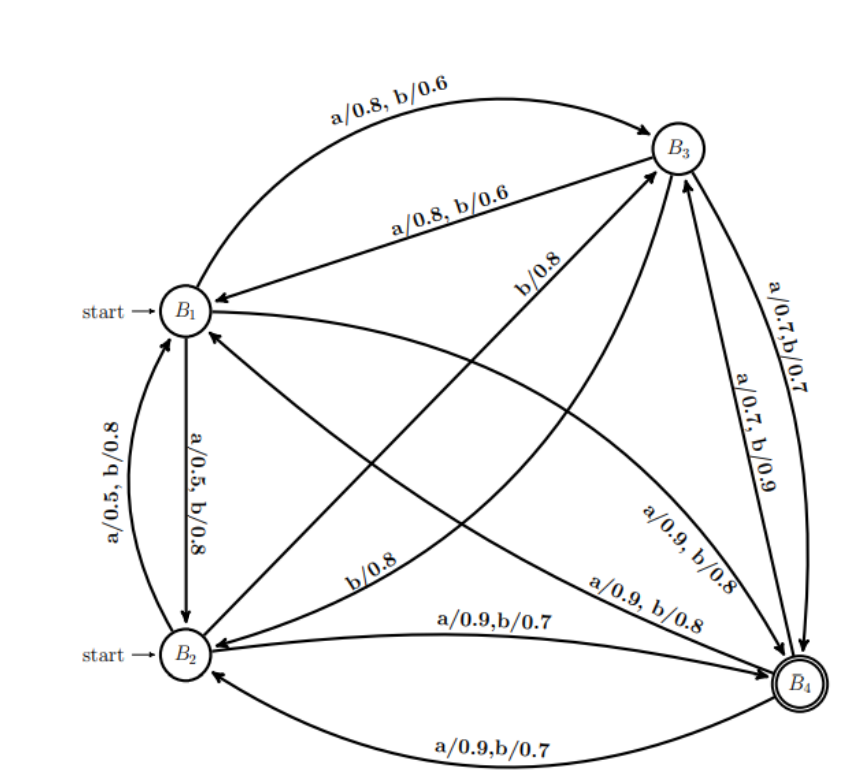
Figure 1. Minimal general finite fuzzy